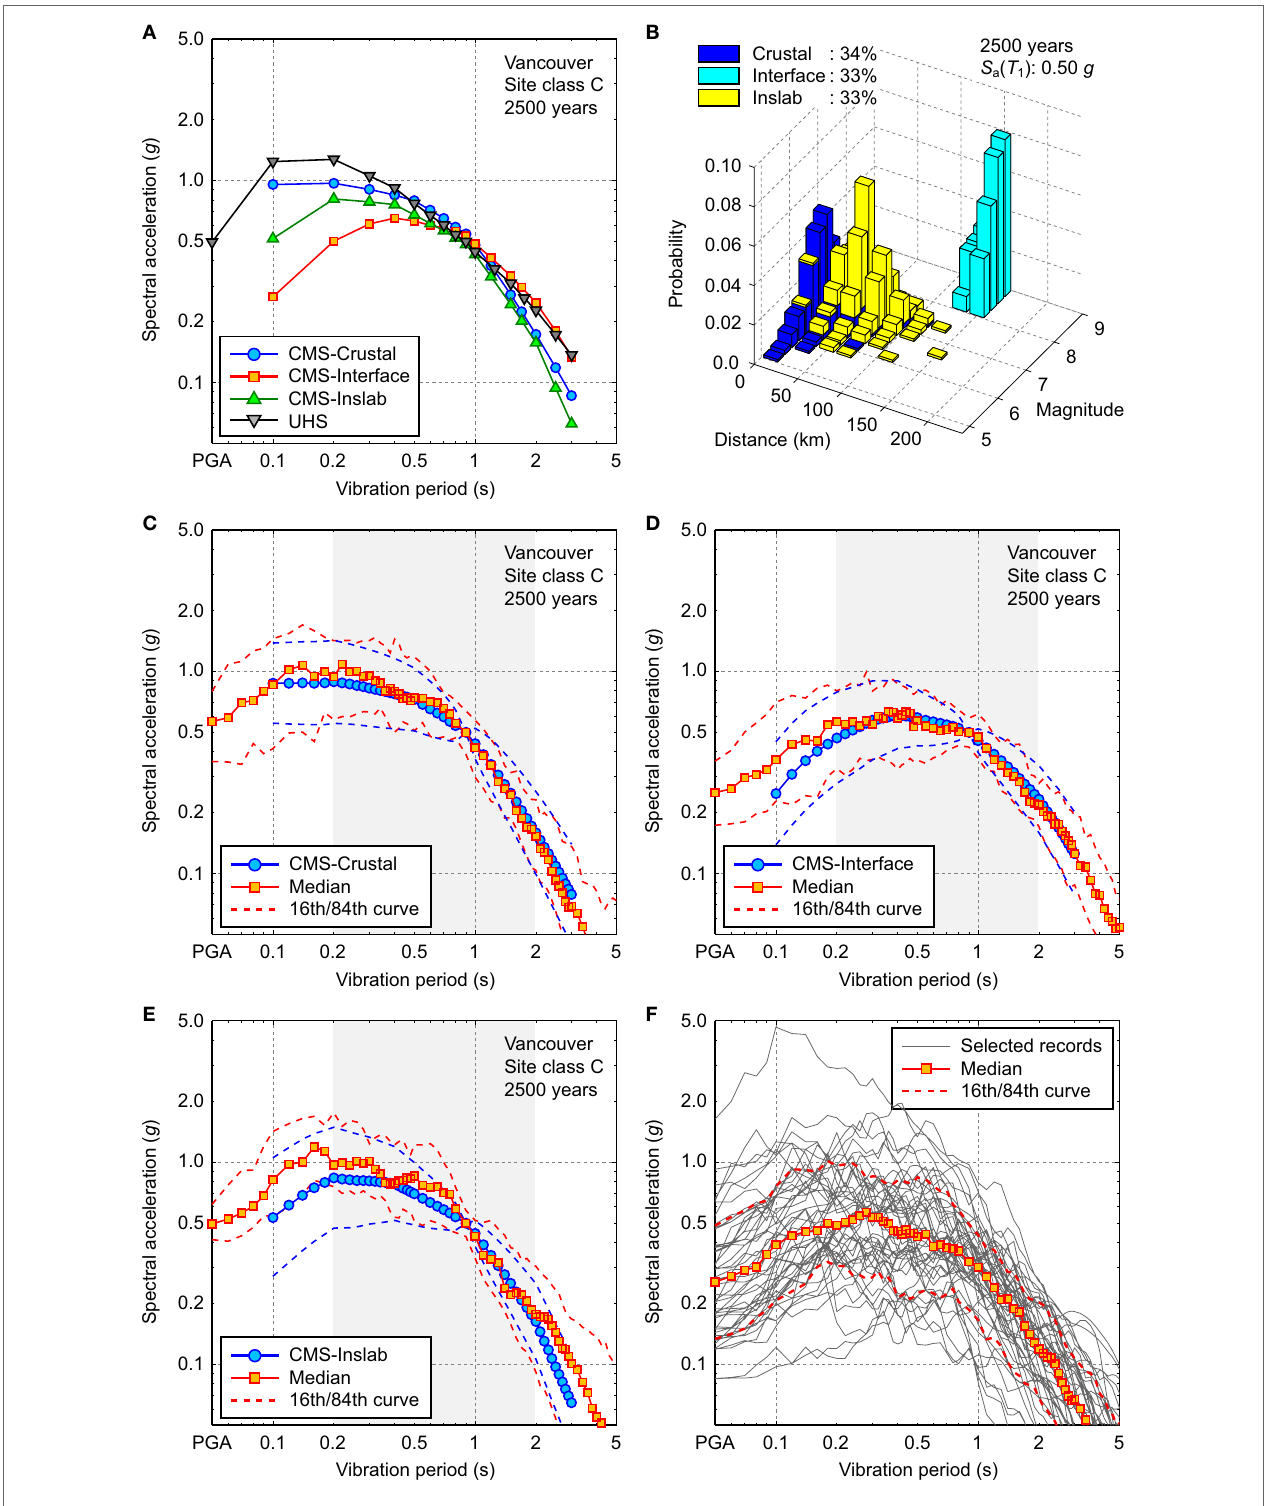
FIGURE 3 | (A) Uniform hazard spectrum and conditional mean spectra for crustal, interface, and inslab events in Vancouver (site class C; return period of 2,500years). (B) Seismic disaggregation for spectral acceleration at 0.9s in Vancouver (site class C; return period of 2,500years). Comparison of response spectra of the selected (mainshock) ground motion records (50th/16th/84th curve) and conditional mean spectra (mean and mean (cid:6) 1 SD): (C) crustal earthquakes, (D) interface earthquakes, and (E) inslab earthquakes. (F) Geometric mean response spectra of the selected mainshock ground motions.